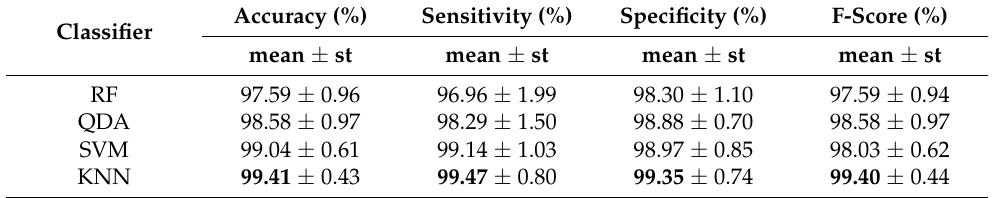
Table 8. Classification results of off–PD vs. HC based on CSP+LogEn (10–30 Hz, SL = 2 s and d =